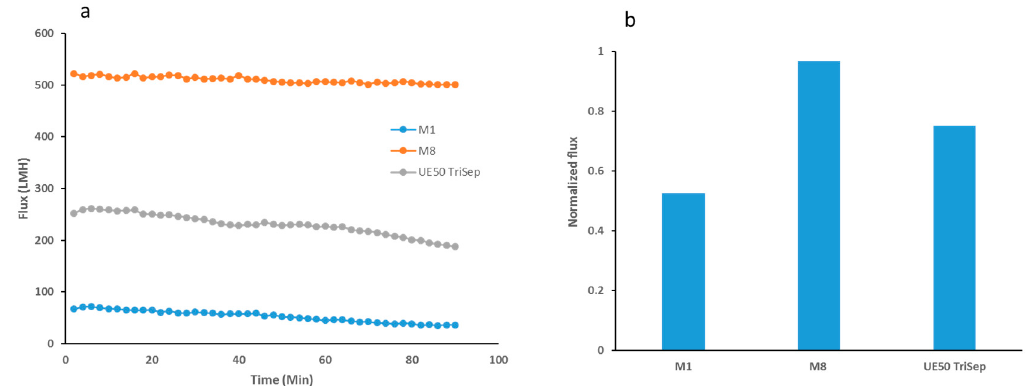
Figure 14. Graph showing flux readings for the filtration of bacterial suspensions for selected fabricated membranes and the UF (ultrafiltration) commercial membrane ( a ) and the normalized flux for each of the three membranes calculated as the final reading at the end of filtration over the initial reading at the beginning of the filtration test ( b ).